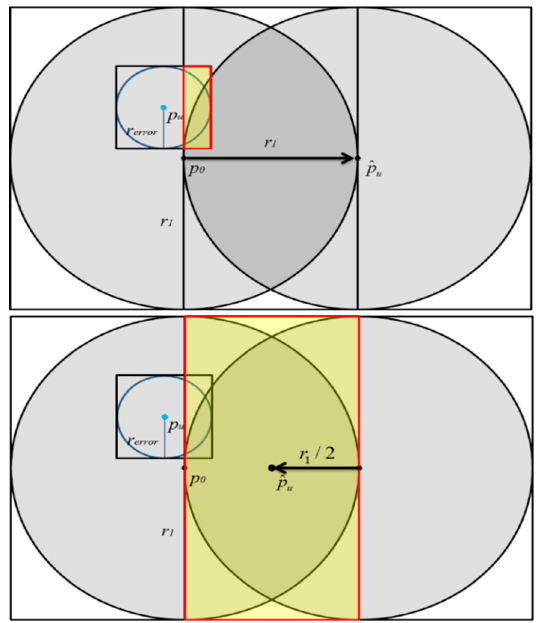
Figure 7. The effect of r error on the localization results of SPAA. Figure 7. The e ff ect of r error on the localization results of